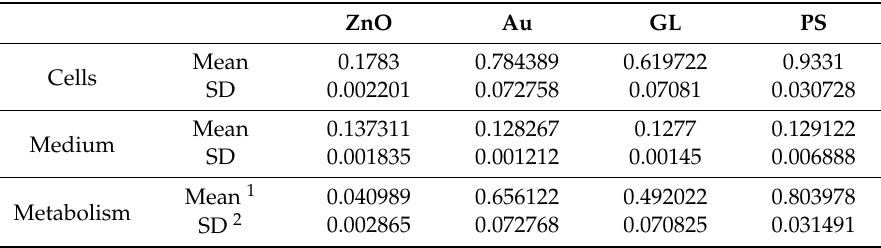
Table 3. The absorbance of the MTT assay of NG108-15 cells.